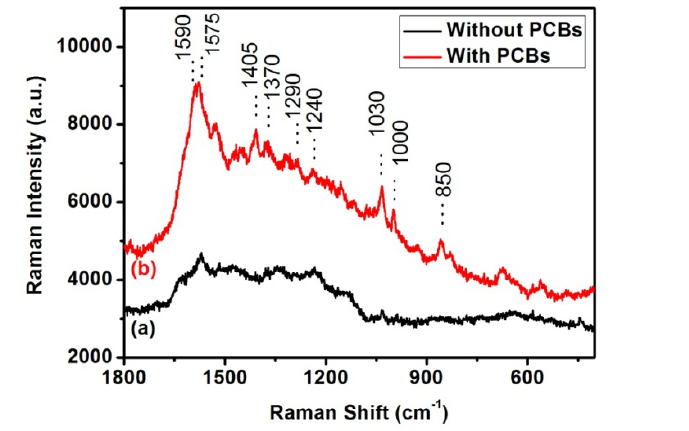
Figure 3. Raman spectra of curve ( a ) Pure distilled spirit; ( b ) Distilled spirit with 10 - 4 mol/L